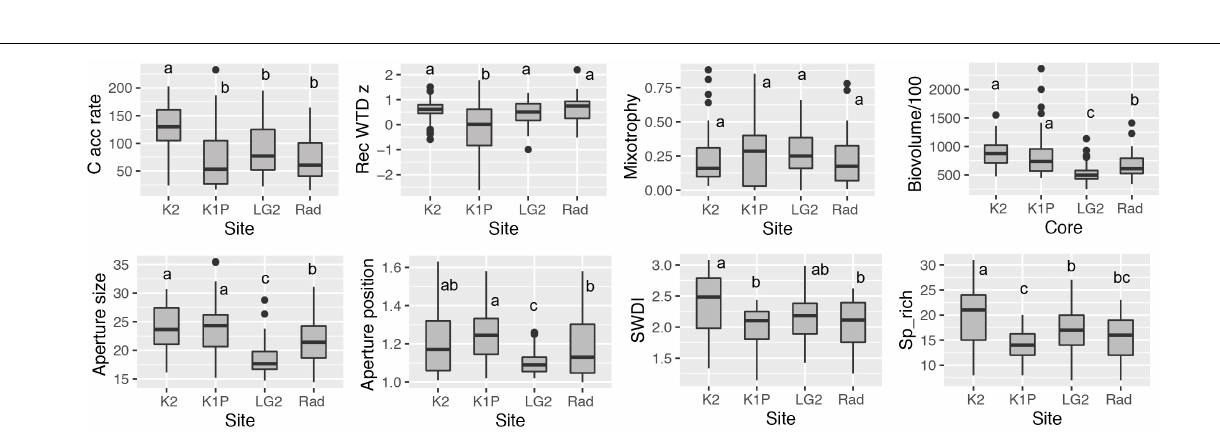
FIGURE 3 | Box plots of carbon accumulation rate (C acc rate; g C m − 2 yr − 1 ), reconstructed water-table depth z score (Rec WTD z ), mixotrophy, biovolume ( µ m 3 ), aperture size ( µ m), aperture position, Shannon-Wiener diversity index (SWDI), species richness (Sp_rich) and at each site. Different letters indicate significant differences ( p < 0.05) among sites calculated using the Turkey’s Honest Significant Difference method. Note the time span of each record included for each site varied and can be found in Figure 4 .